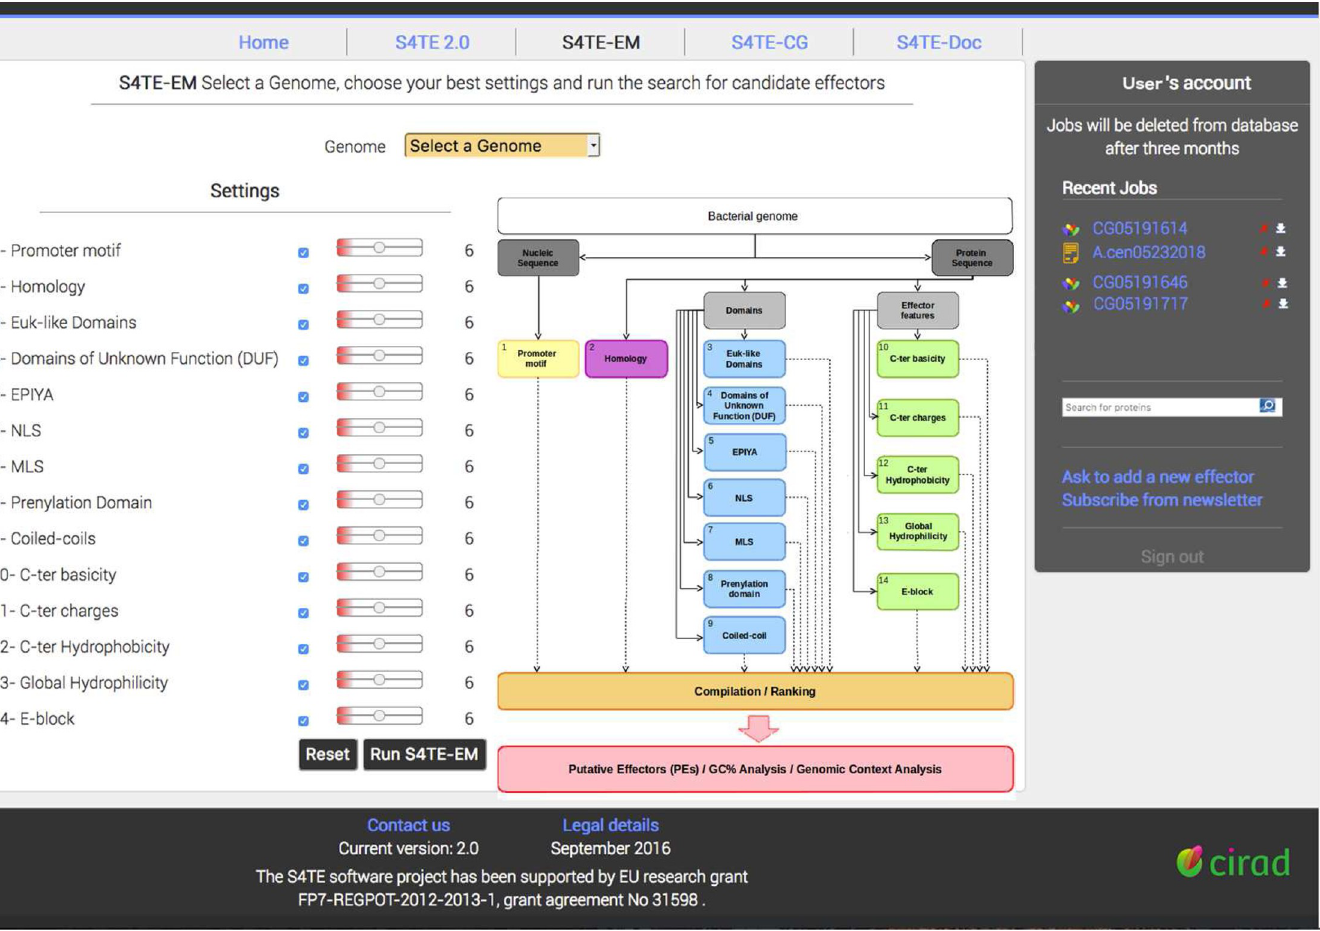
Fig 5. The new front page of the S4TE-EM tool. The right side provides some information about the page. The right side matches the user account. The user account shows all the jobs previously ran in S4TE 2.0 and S4TE-CG. This account makes it possible to search for a protein with the search bar and to ask to add a proven T4 effector in the database. In the central part of the workspace, the user can select a genome in the drop-down menu. In S4TE-EM, the user can change the weighting or disable one or more modules (on the left) shown in the S4TE diagram (on the right) and run S4TE-EM by clicking on the ‘Run S4TE-EM’ button.